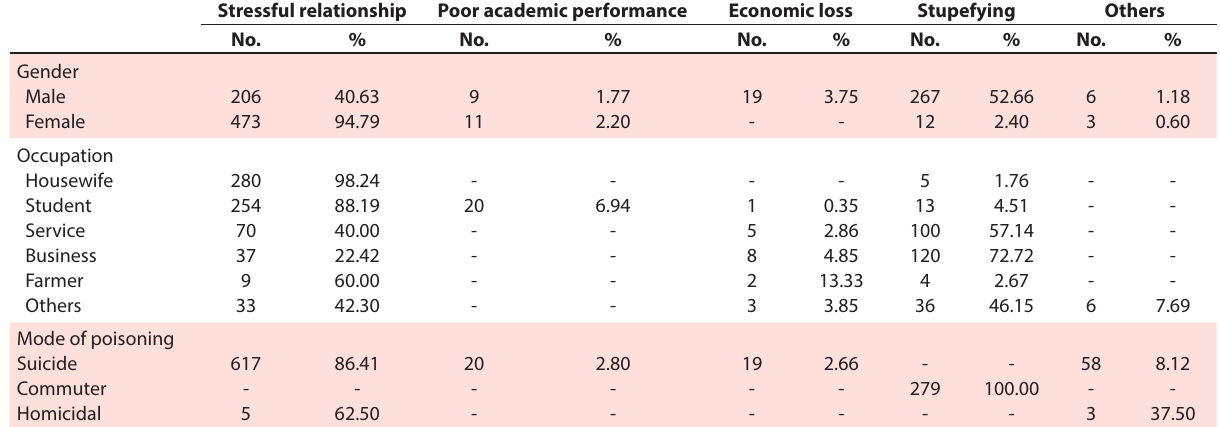
Table 2. Provocative factors of